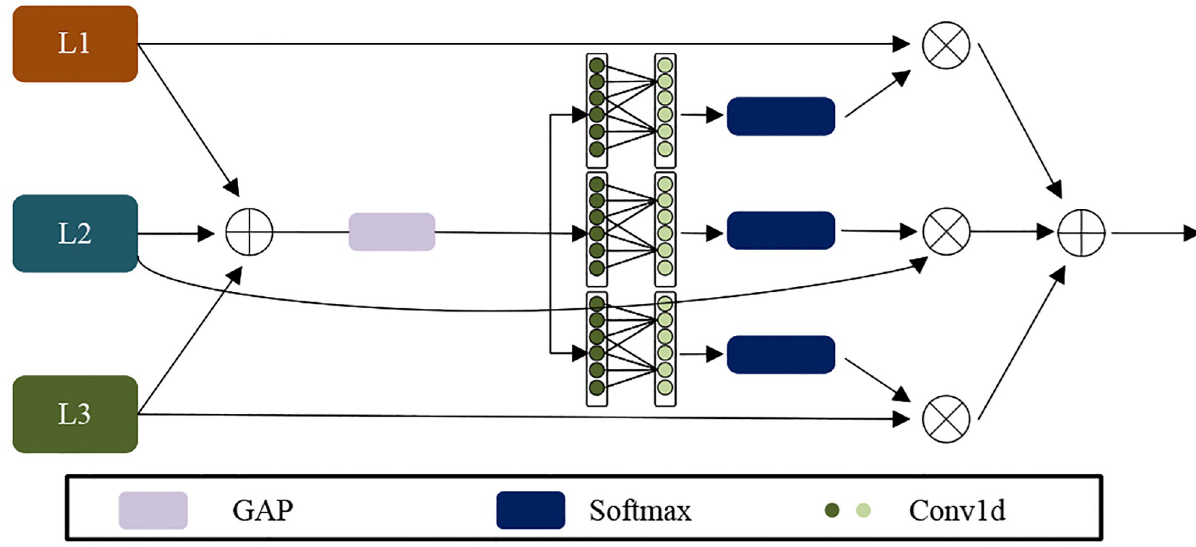
Fig 4. The structure of our proposed AFAB. We set the kernel of Conv1d as 3.